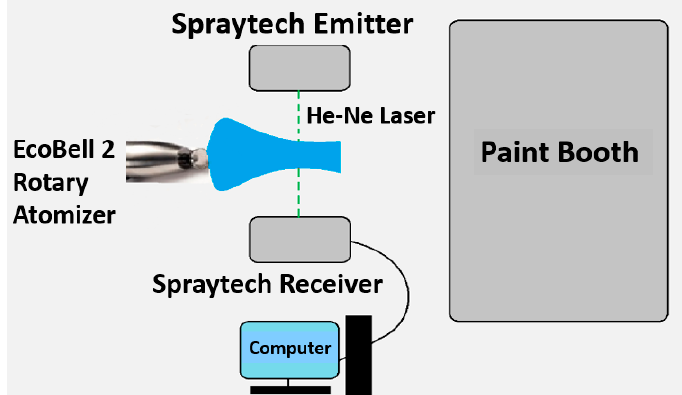
Figure 2. A schematic of the experimental setup.